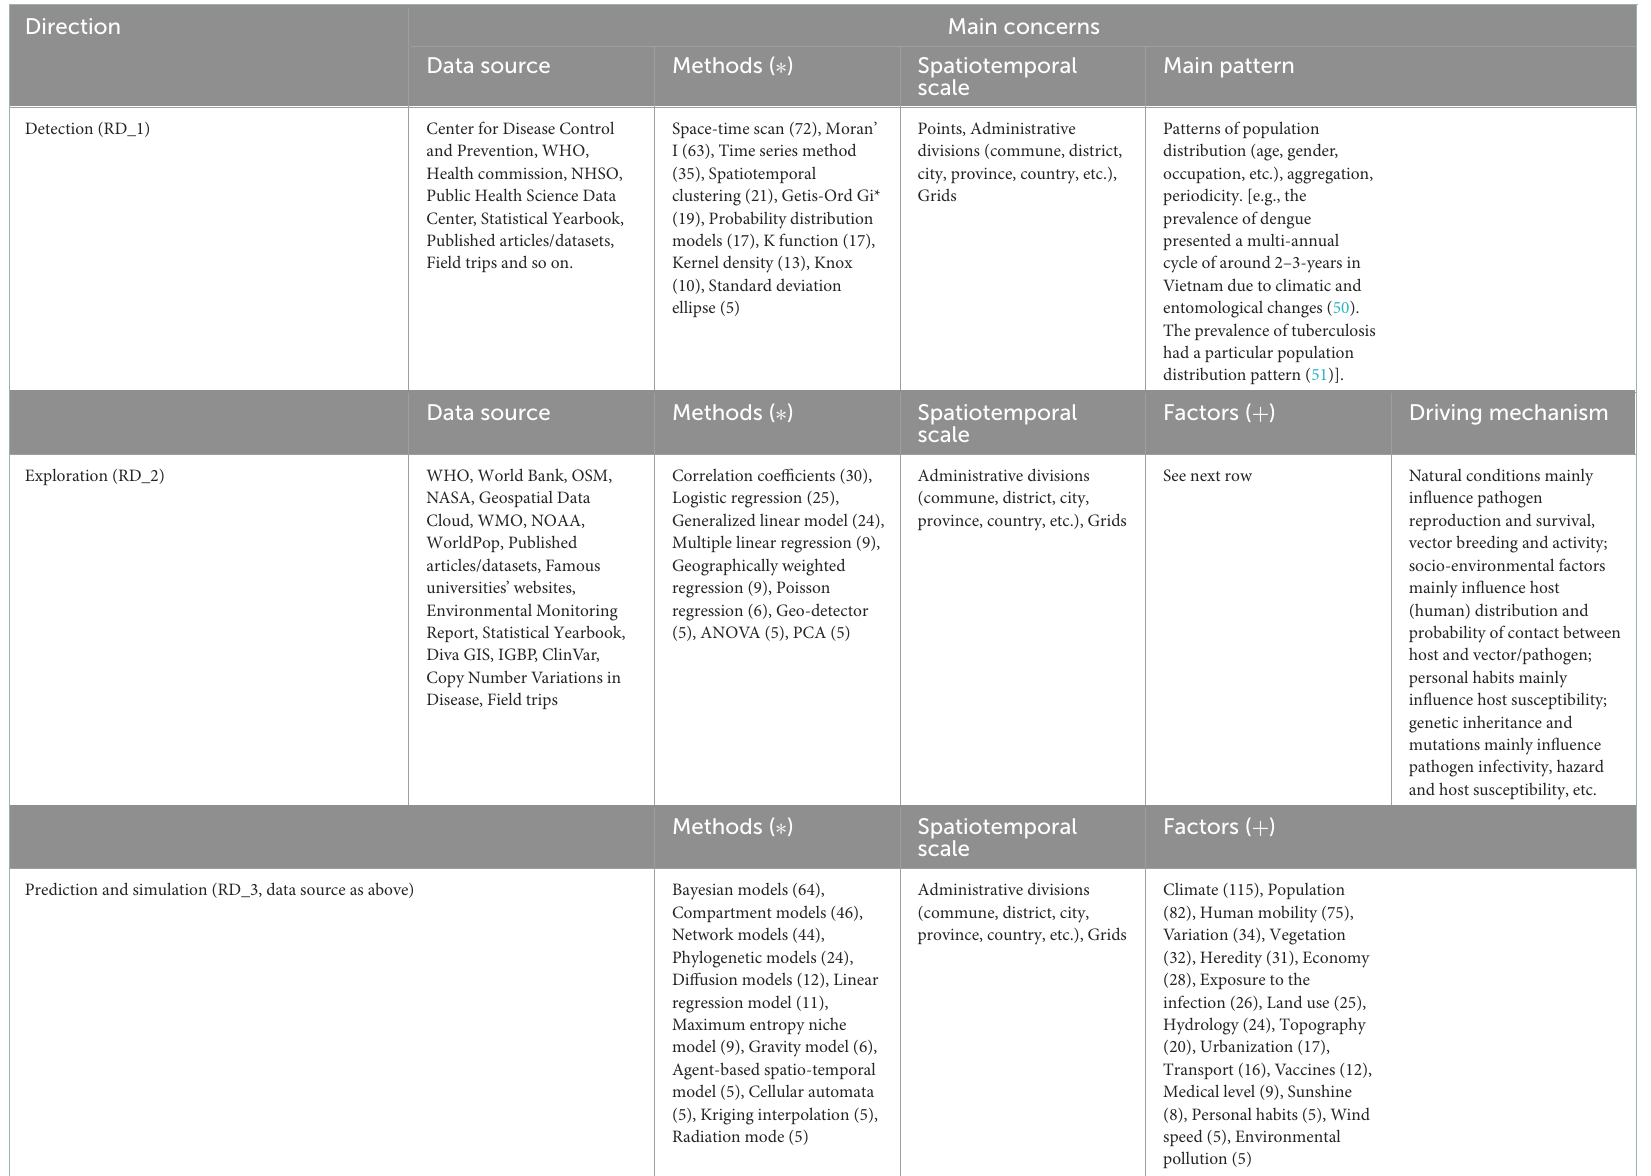
TABLE 2 Research directions